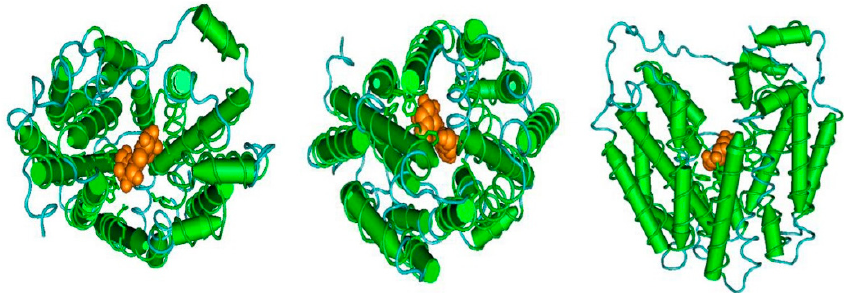
Figure 12. Three-dimensional structural models of protein LoSUT2 and LoSUT4. The software Cn3D was used to show three-dimensional structural models of Major Facilitator Superfamily domain (MFS).